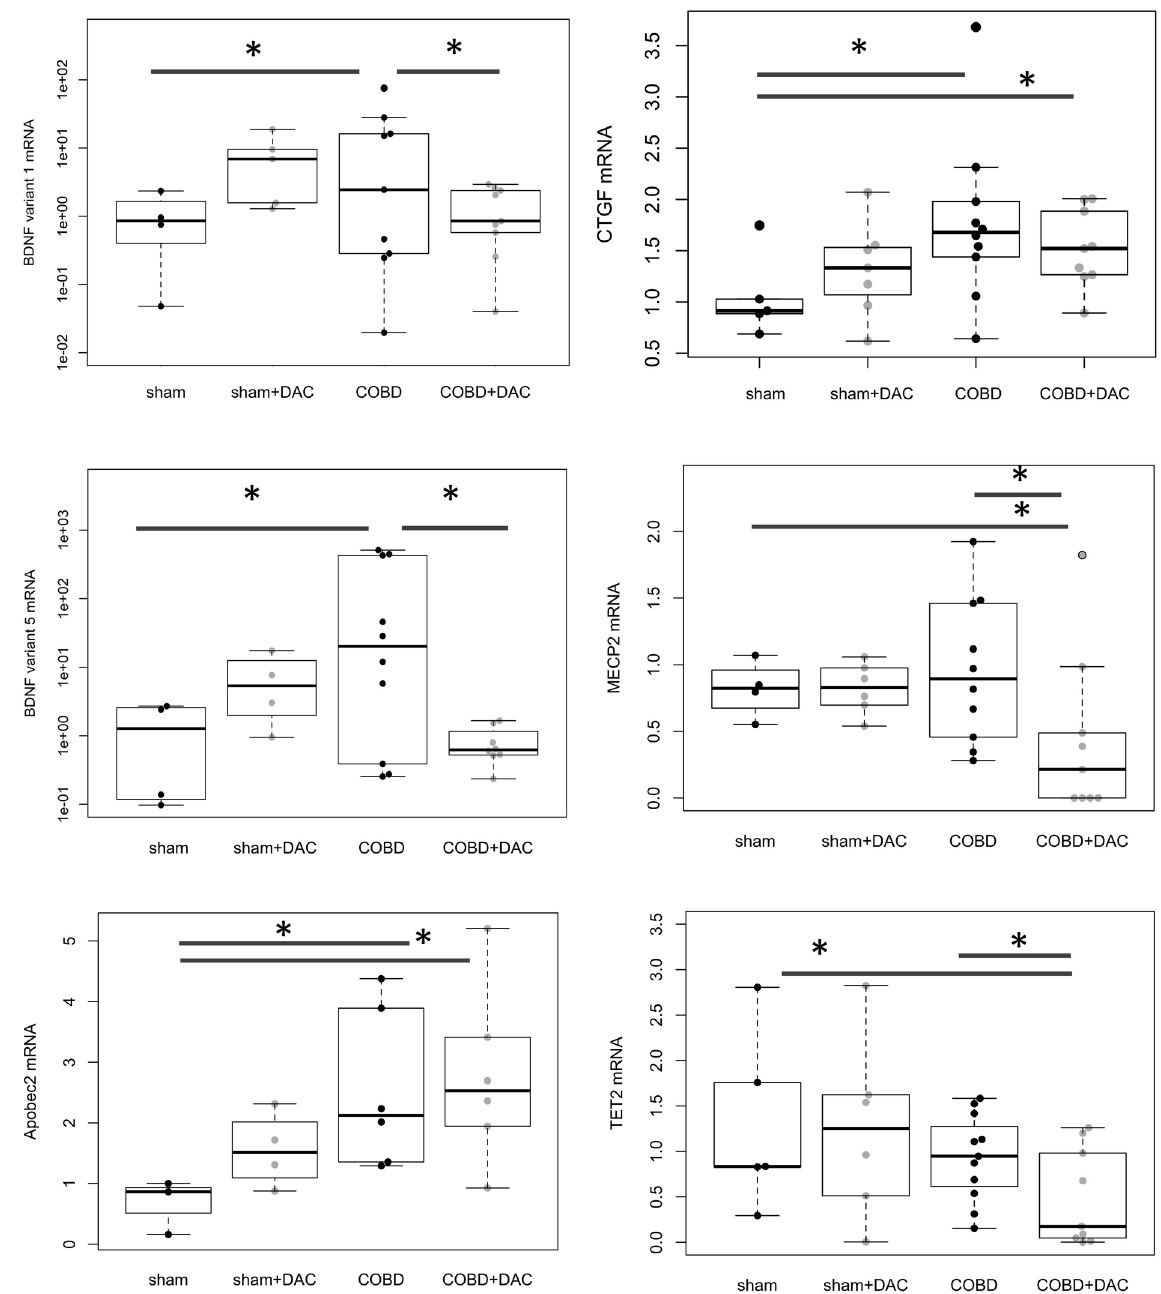
Figure 3. Expression of obstruction- and DAC-responsive genes is altered during COBD. qPCR was performed in COBD bladder tissues to determine expression of genes which we previously found to be restricted by DNA methylation during obstruction 26 in contrast to after de-obstruction. BDNF variants 1 and 5 (exons VI and IV) shown here increased significantly with COBD and decreased with DAC treatment in COBD. CTGF was increased with COBD and remained upregulated despite DAC treatment. MECP2, which is a regulator of BDNF, was significantly downregulated with DAC, though during COBD it only tended towards upregulation. We also examined genes regulating DNA de-methylation, APOBEC2 and TET2. APOBEC2 was upregulated with COBD and COBD + DAC. TET2 showed a downregulation with COBD and DAC treatment vs. either sham or COBD alone. Expression of other genes implicated in COBD in the bladder were also examined in Supplemental Fig. S4, but none of these genes showed expression patterns concordant with BDNF mRNA expression. *p <